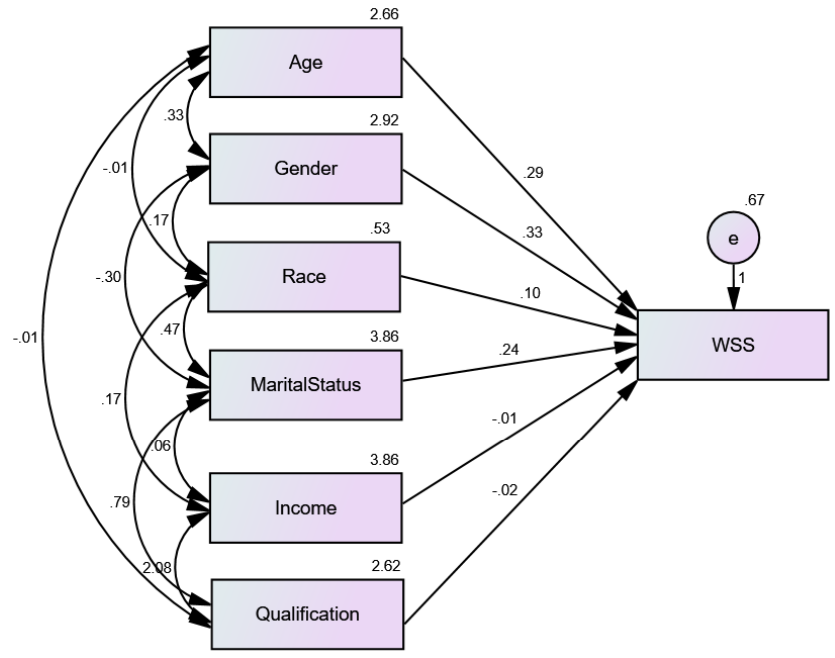
Figure 2: A causal model showing the path coefficients of the influence of demographic variables on early childhood work- stimulated stress.